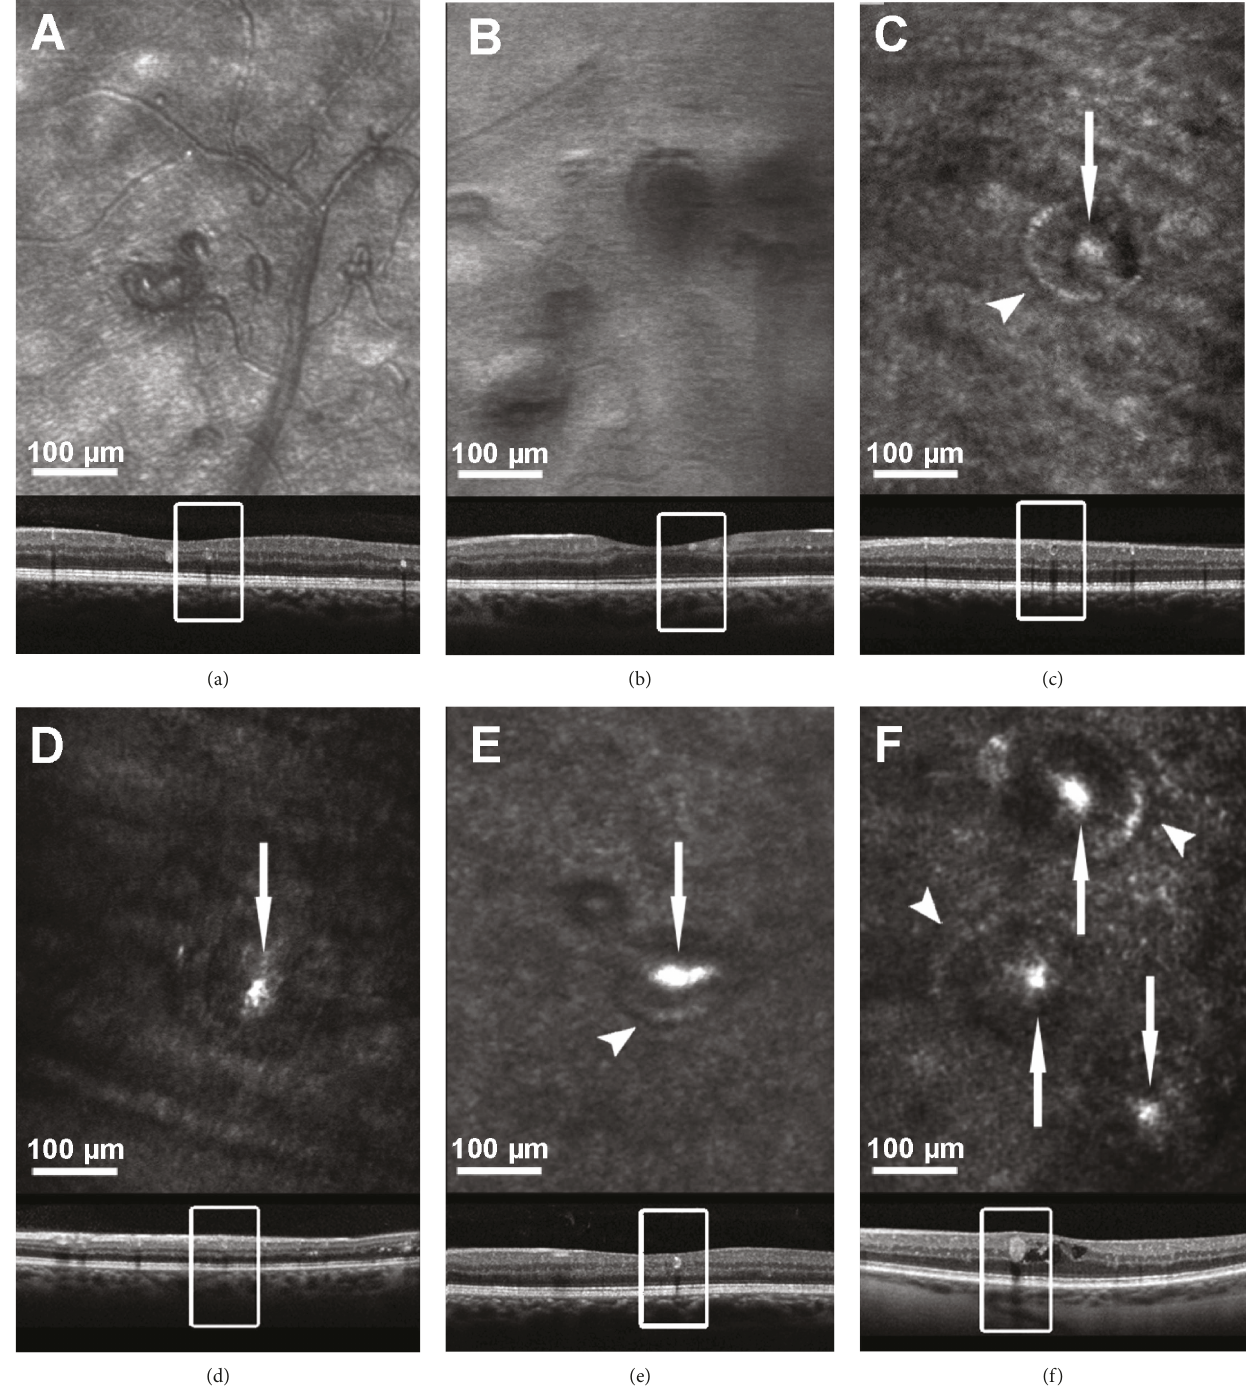
Figure 3: Six examples of microaneurysms (MA) on AOSLO. The rectangles indicate the MA location in the corresponding SDOCT B-scans. Some MAs have hyperre fl ective vessel walls (arrowhead) or intraluminal hyperre fl ective structures (arrow) in AOSLO images (c – f). Using MSL AOSLO imaging (a, b), MA vessel walls are more clearly visible compared to confocal AOSLO imaging (c –